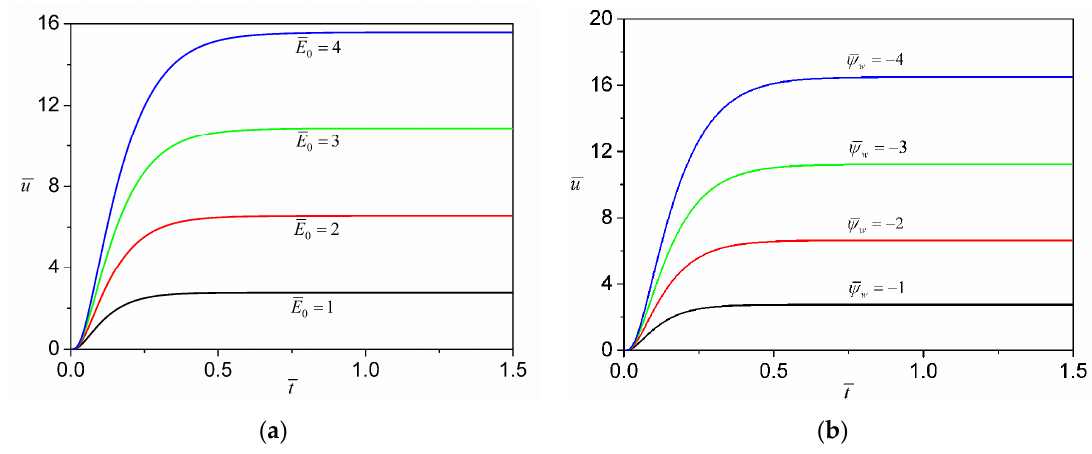
Figure 5. ( a ) Comparison of transient development of the axial velocity at the transverse center ( z = y = 0) under different magnitudes of external electric field strength when n = 0.8 and ψ w = − 1; ( b ) Comparison of transient development of the axial velocity at the transverse center ( z = y = 0) for different magnitudes of zeta potential when n = 0.8 and E 0 = 0